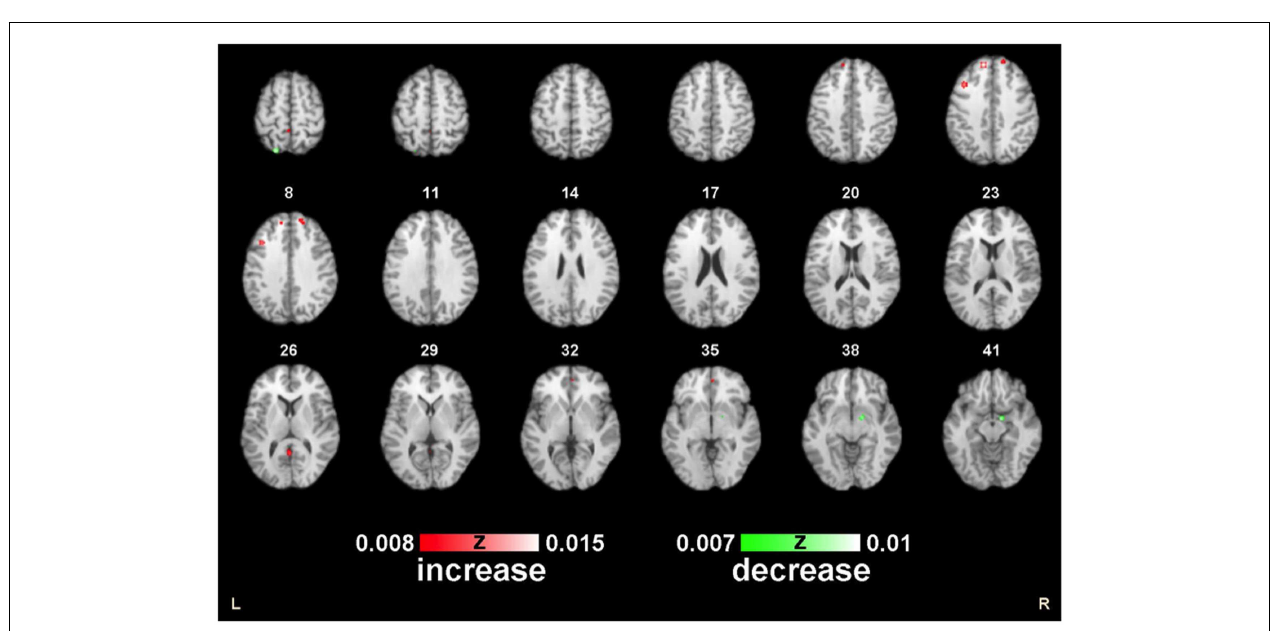
FIGURE 2 |ALE map of the postmenopausal women during working memory . Decreased (green) and increased (red) activity following HT compared with the controls ( p < 0.01; FDR-corrected; k > 100).